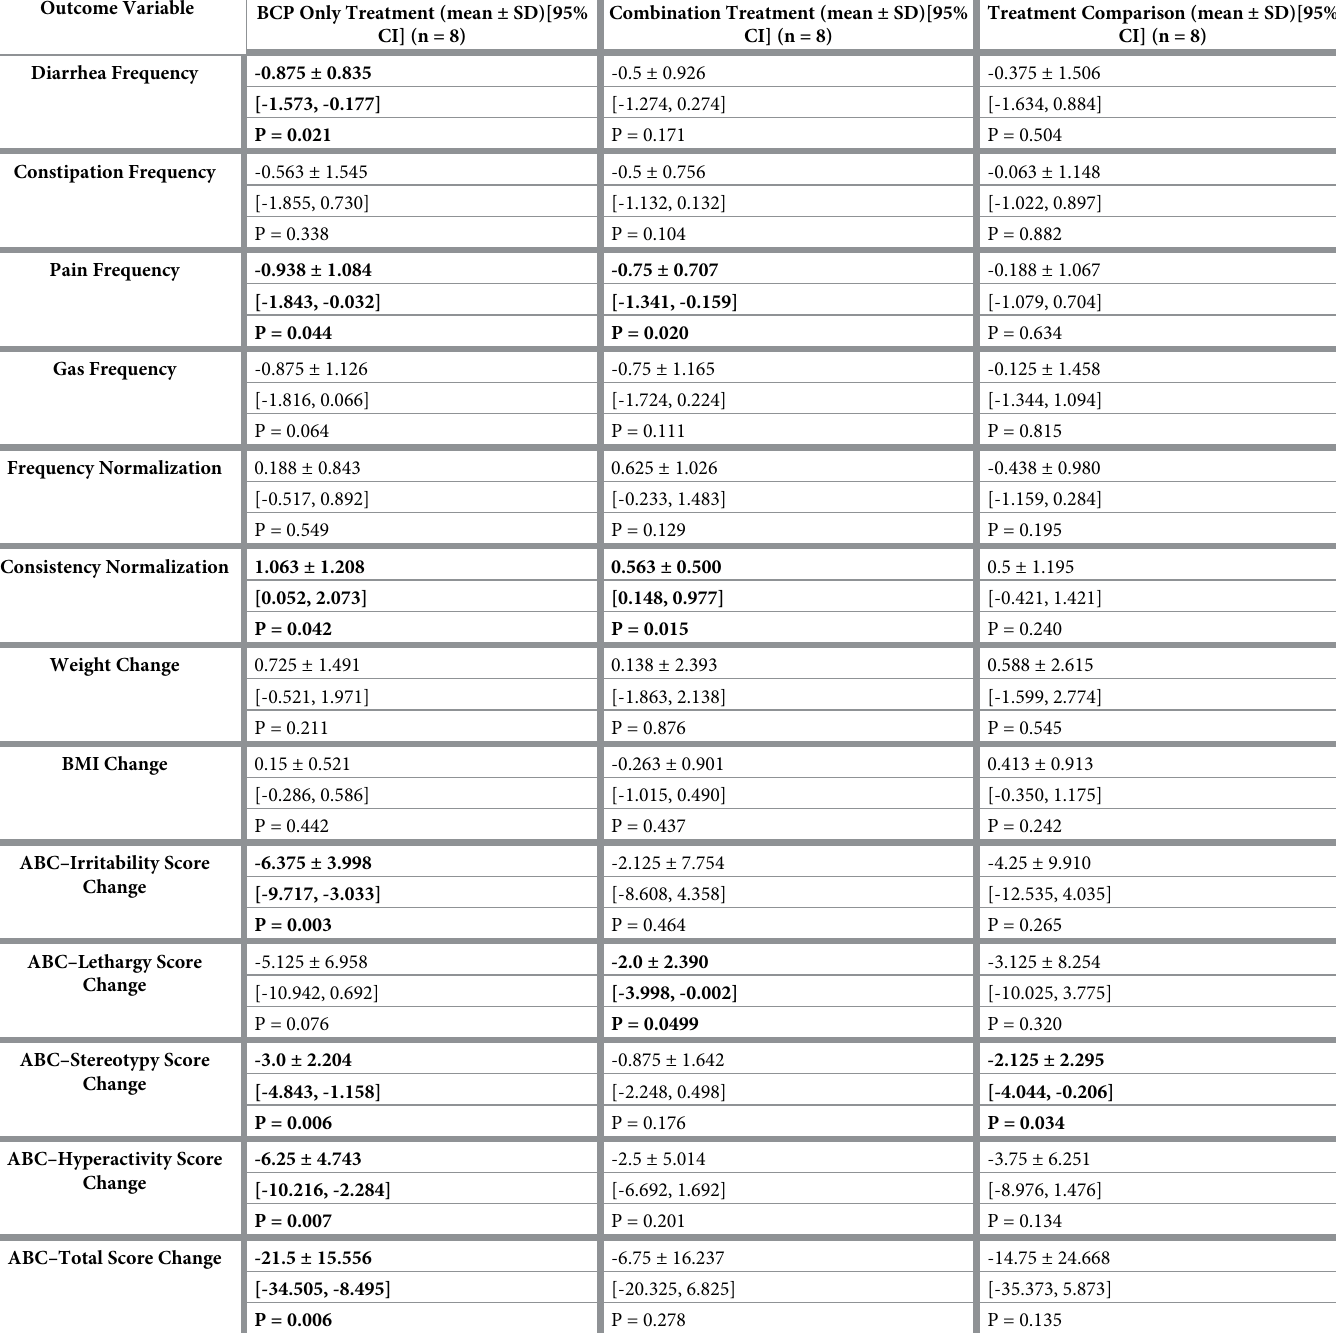
Table 3. Confidence intervals and p-values for gastrointestinal and behavioral questionnaire